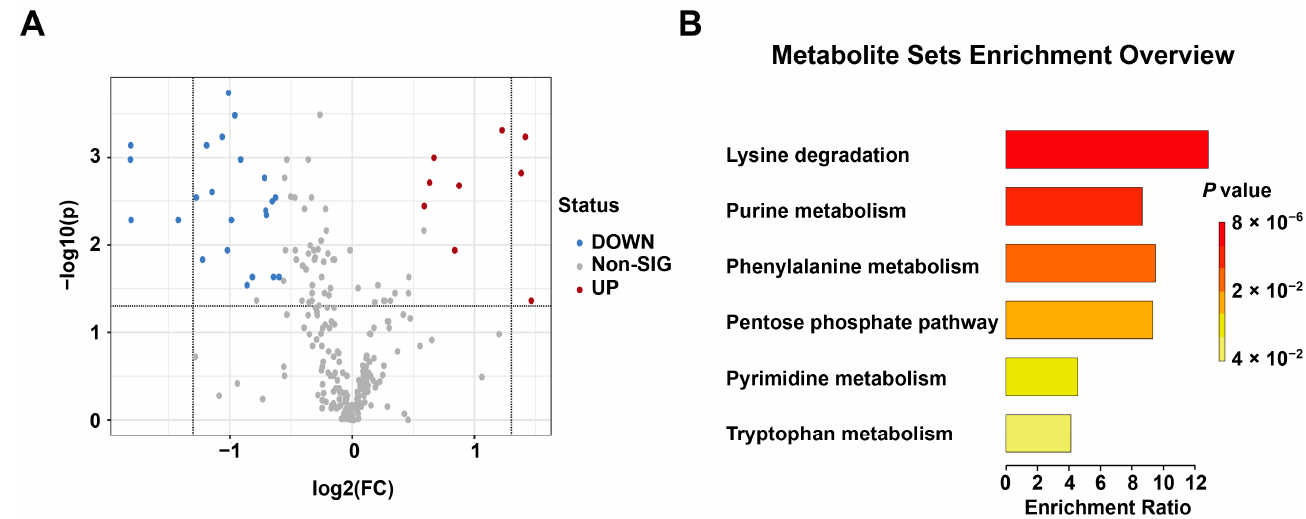
Figure 8. Exploring a new toxicological mechanism of estazolam in brainstem tissue samples between EFI and EIND groups (n animal = 10, respectively). ( A ) Volcano plot of the EFI and EIND group, with nine up-regulated (red points) and 23 down-regulated (blue) differential metabolites. ( B ) In the plot for quantitative enrichment analysis of differential metabolites, the most perturbed pathway is the lysine degradation pathway.